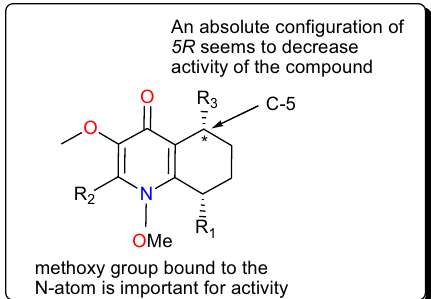
Fig. 5 SAR for W. indica compounds inhibiting T. cruzi , T. b. brucei and T. b. rhodesiense